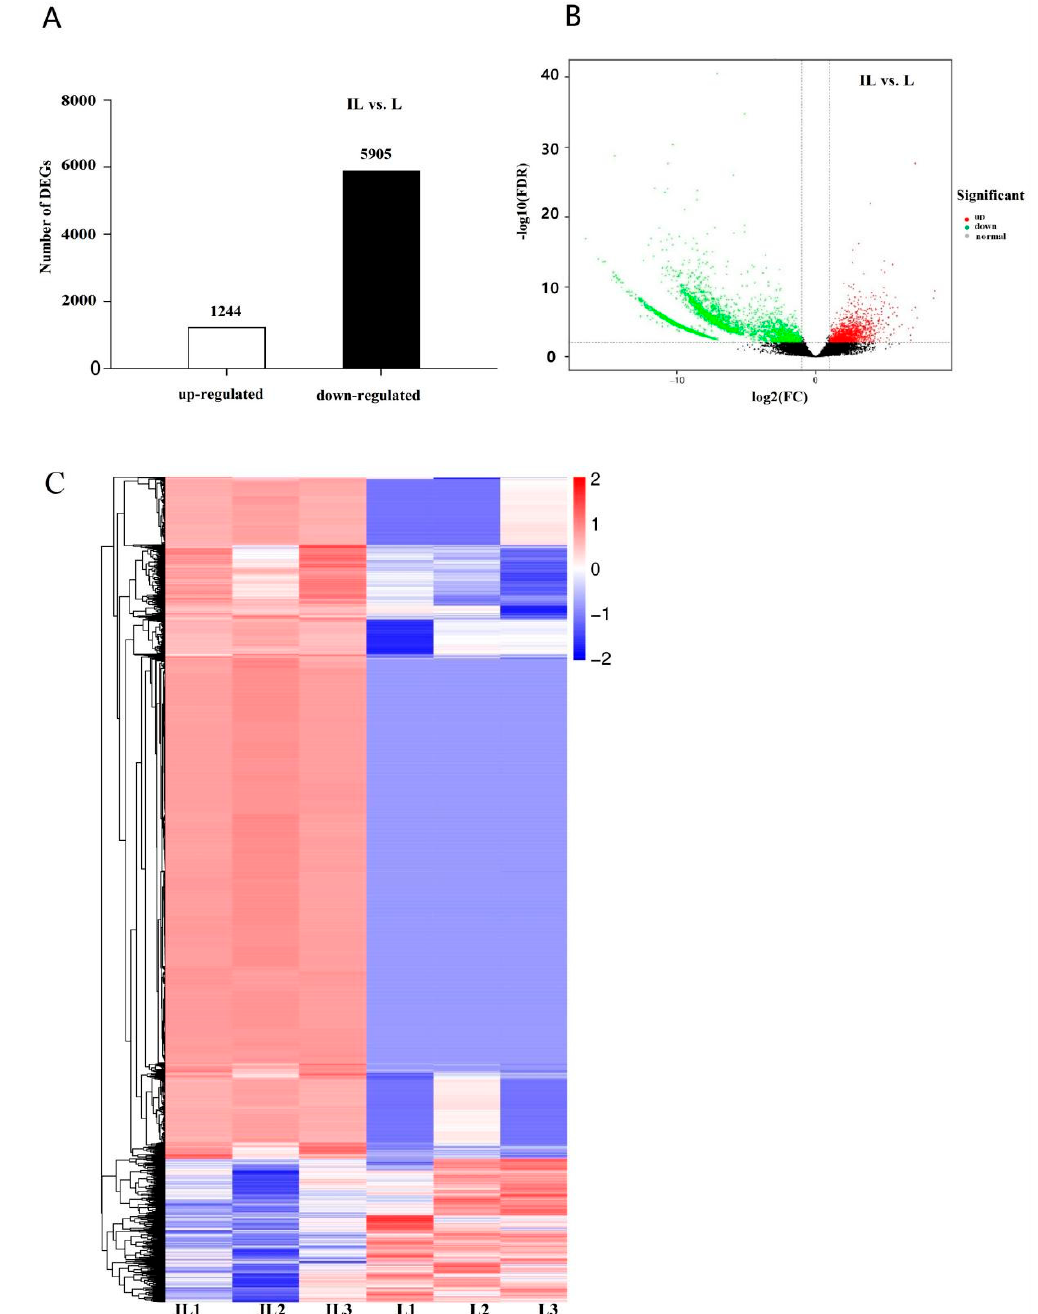
Figure 2. The analysis of differentially expressed genes (DEGs) in IL and L. The histograms of DEGs in groups. ( A ). The number of DEGs is shown on the top of histograms. ( B ). The volcano map of the DEGs in IL vs. L, with each point indicating the differentially expressed genes and the abscissa representing the logarithm of the expression multiple of a gene in the two groups. Green represents downregulation of gene expression in L compared to IL, red represents upregulation of gene expression in L compared to IL, and black dots represent genes with no significant expression differences. ( C ). Hierarchical clustering of differentially expressed genes. Each column represents one sample. Rows represent different genes. The expression level of genes (FPKM) was normalized by log2, and blue color represents the downregulated gene, while red color represents the upregulated genes. L represents the pre-infected larva of H . xiaojinensis . IL represents the one year post-infected larva of H . xiaojinensis by O. sinensis